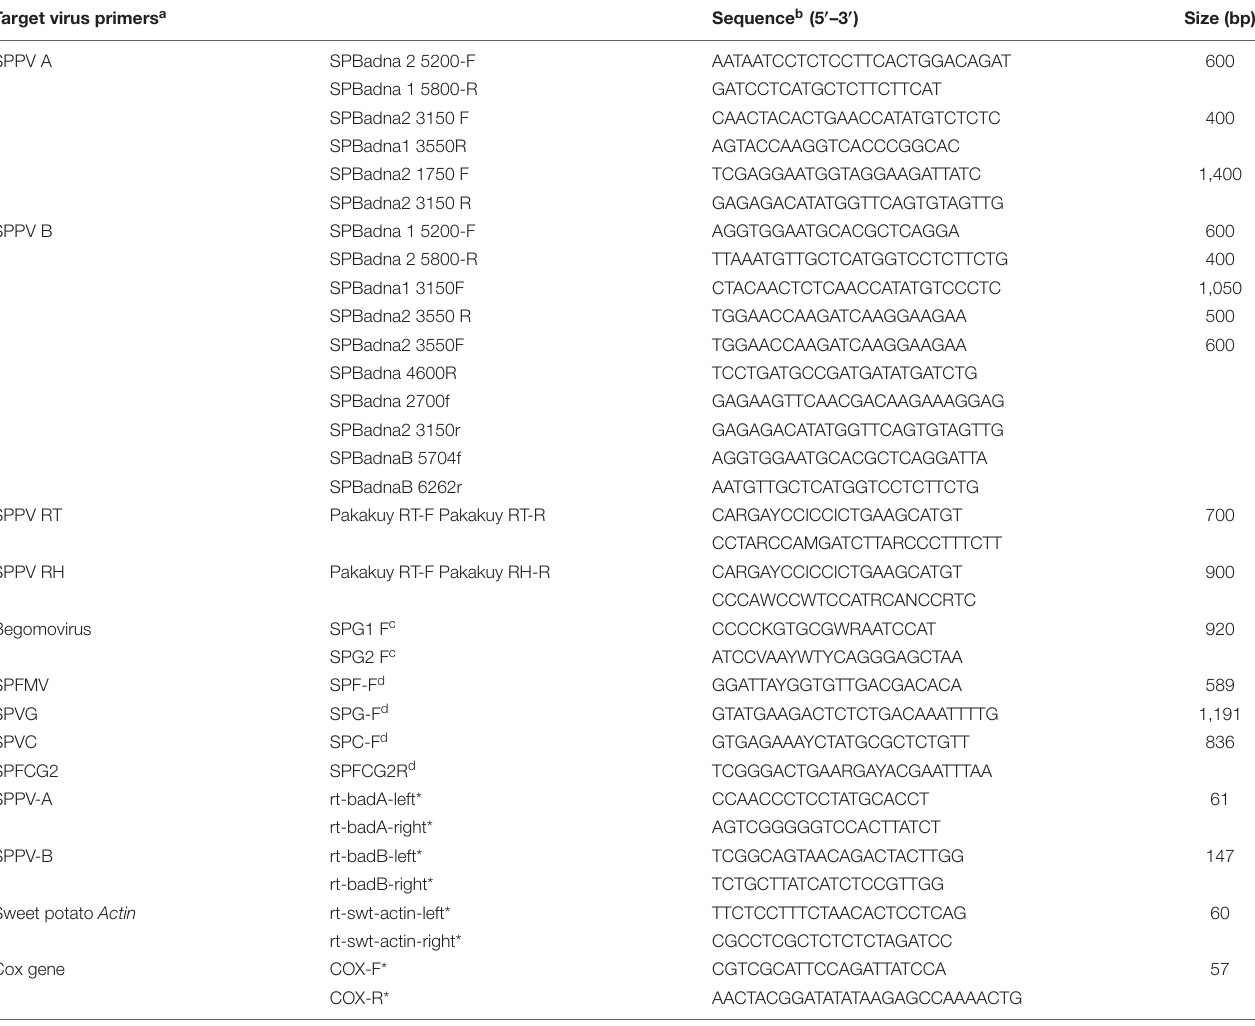
TABLE 1 | List of primers used in the detection for SPPV and qRT-PCR. Target virus primers a Sequence b (5 (cid:48) –3 (cid:48)